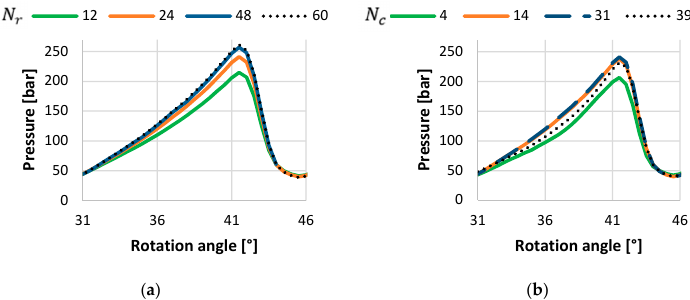
Figure 11. Influence of ( a ) N r at N c = 31 and ( b ) N c at N r = 24 on the pressure surge when the displacement chamber connects to the delivery port.